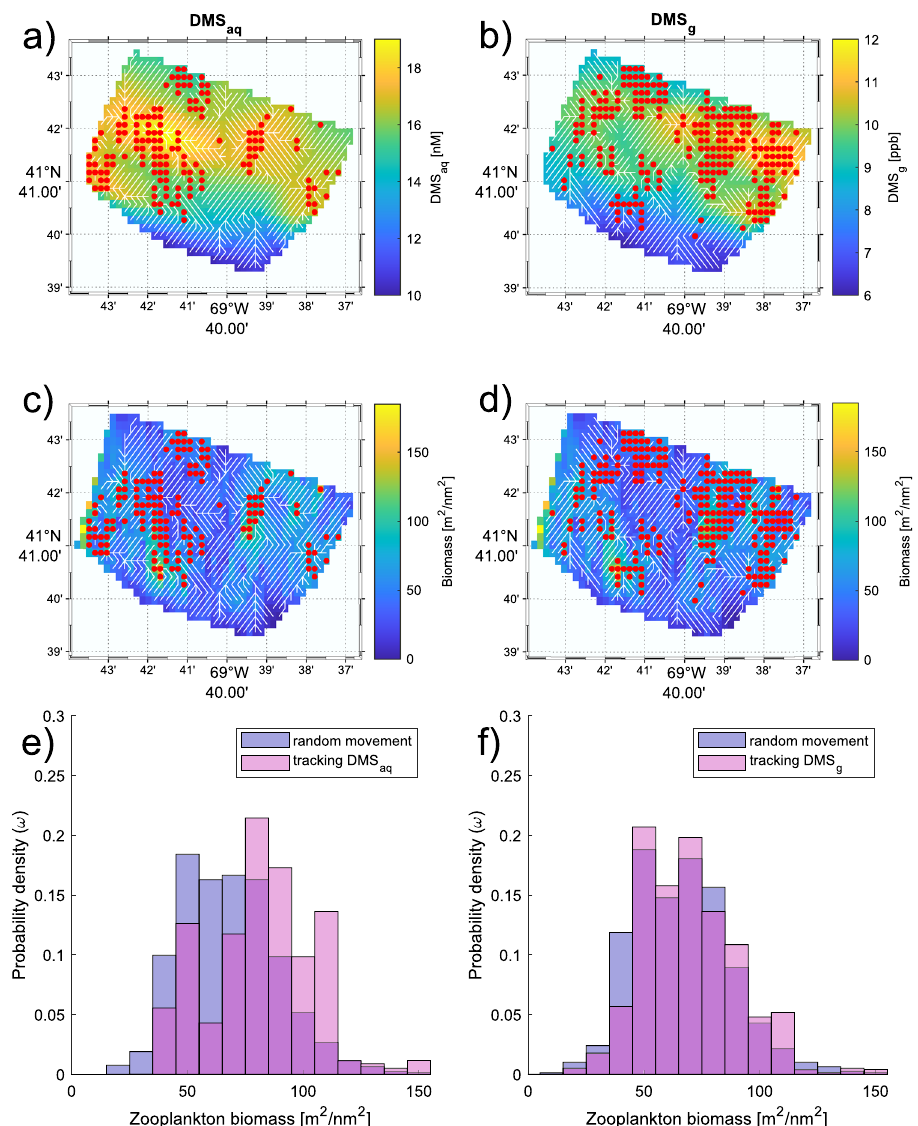
Fig. 5 Agent simulation models of potential predator movement through gradients of dimethyl sul fi de (DMS). Results are presented for seawater (DMS aq ) and air (DMS g ). Agent movements are shown as white lines, and the grid areas ( n = 793) where the highest prey biomass was reached are shown as red dots. a Agent paths from the tracking DMS experiment in seawater overlaid onto DMS aq concentration. b Agent paths from the tracking DMS experiment in air overlaid onto DMS g concentration. c Agent paths from the tracking DMS experiment in seawater overlaid onto zooplankton biomass. d Agent paths from the tracking DMS experiment in air overlaid onto zooplankton biomass. e The distribution of prey biomass encountered while moving randomly (random movement experiment — mean of the maximum of 1000 iterations) (blue) and while tracking DMS aq concentration (tracking DMS experiment- one iteration since it is deterministic) (purple). f The distribution of prey biomass encountered while moving randomly (random movement experiment — mean of the maximum of 1000 iterations) (blue) and while tracking DMS g concentration (tracking DMS experiment — one iteration since it is deterministic)